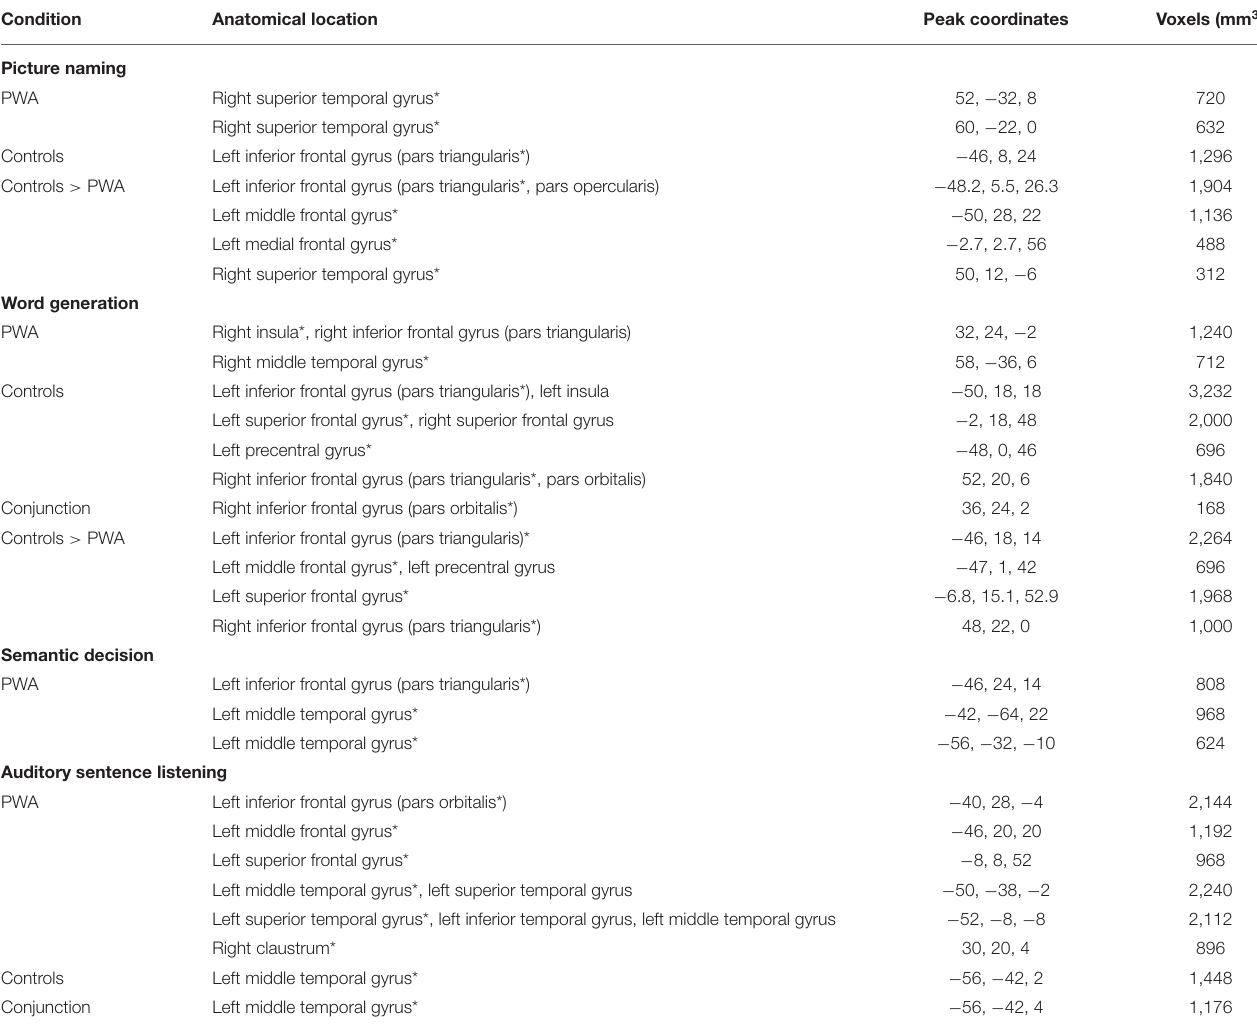
TABLE 5 | Anatomical locations of peak coordinates and cluster size for each single condition ALE in PWA and controls, as well as contrast ALEs comparing PWA and controls on each individual language task.